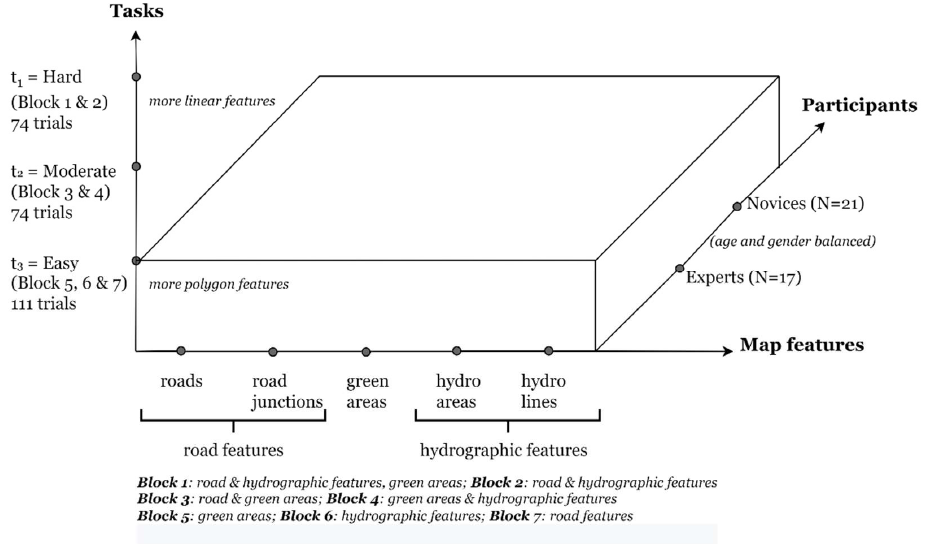
Figure 1. Overview of the experiment design. Blocks are further explained in Section